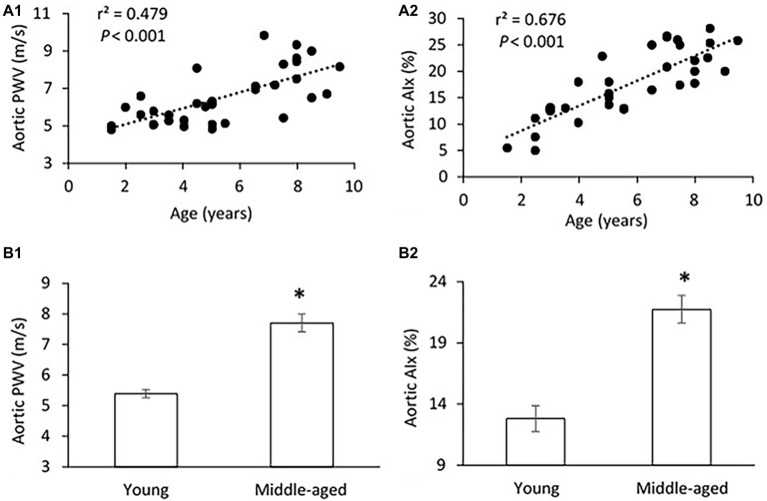
(A) Correlations of aortic pulse wave velocity (PWV) (A1) and augmentation index (AIx) (A2) with age. The linear regression analysis was conducted, and data are expressed as correlation coefficients and significance levels (r2; p). (B) Comparison of aortic PWV (B1) and AIx (B2) between young and middle-aged pigs. Data corresponds to means ± standard error of mean (mean ± SEM). p < 0.05, when compared to young group.